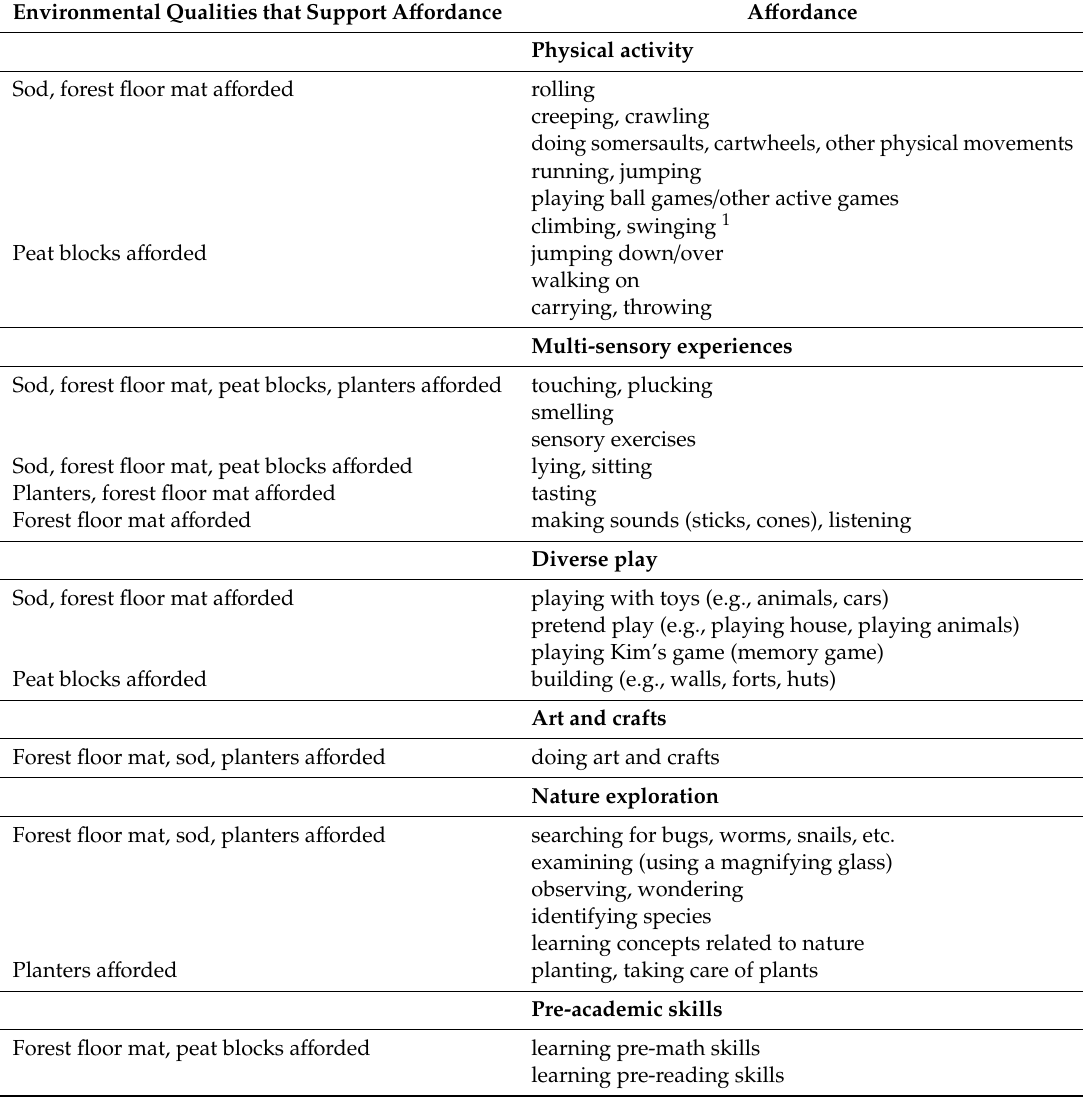
Table 3. Functional a ff ordances enabled by green daycare